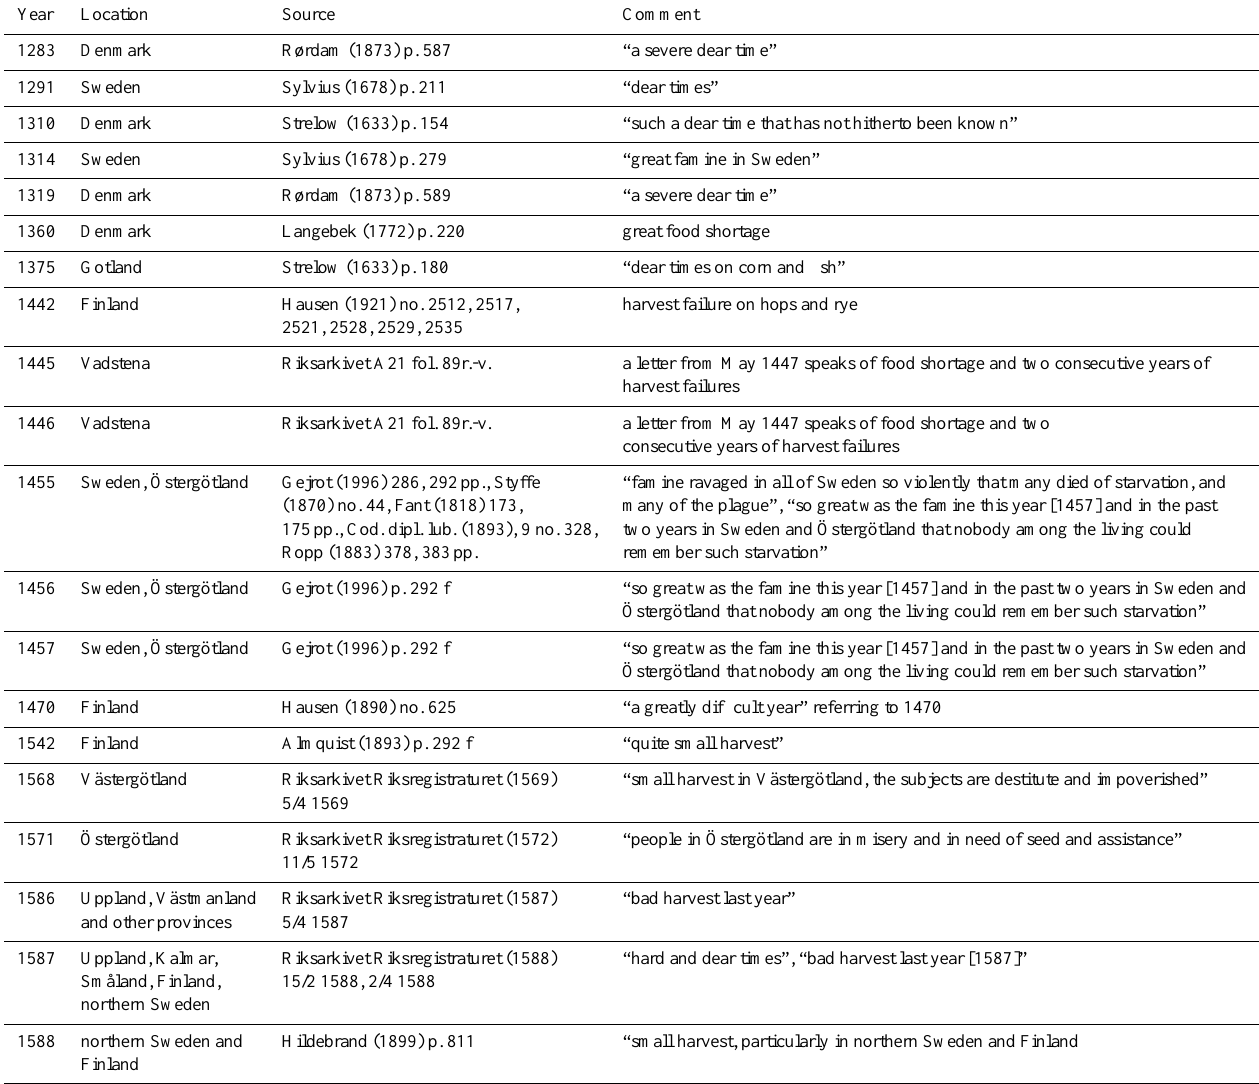
Table B1. Documentary data on harvest failures related to Sweden, 1200–1600, without specified